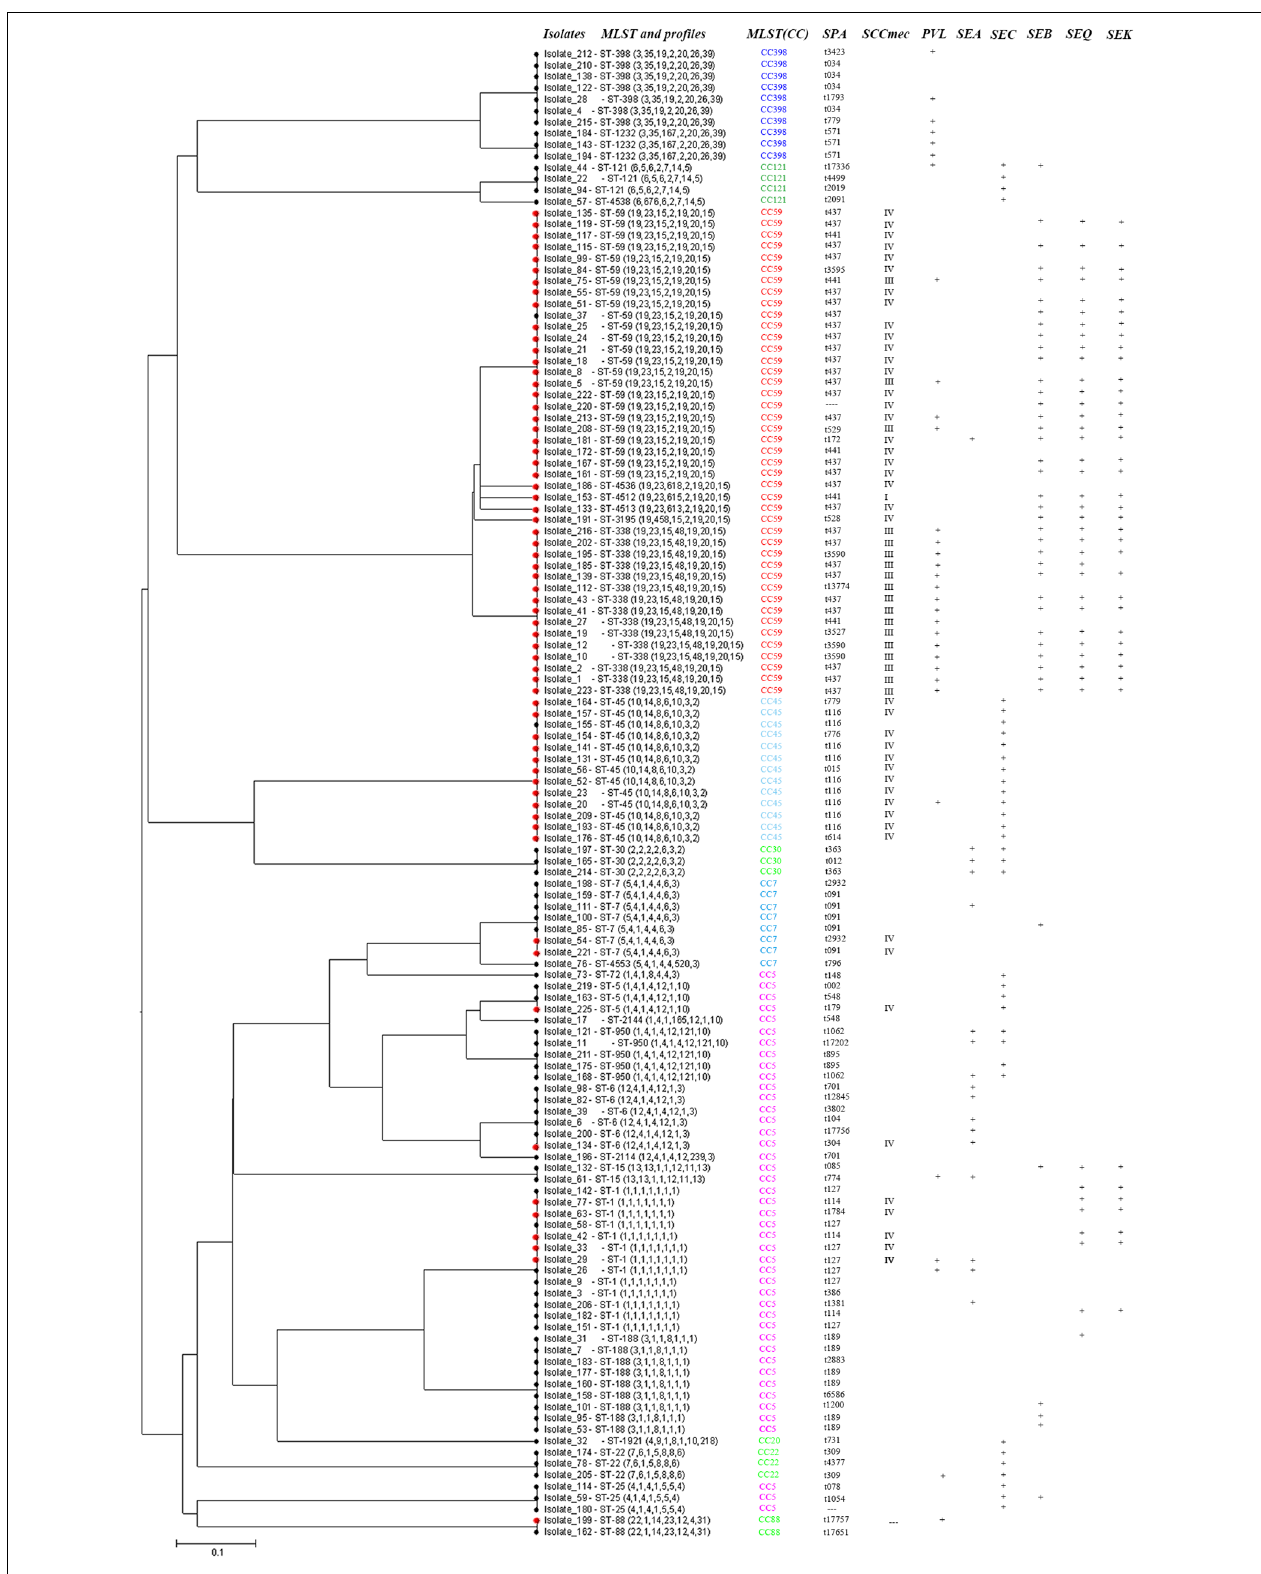
FIGURE 1 | START2 analysis, genotypes, and virulence genes of 131 clinical strains of Staphylococcus aureus isolated from women and children in Guangzhou, China.